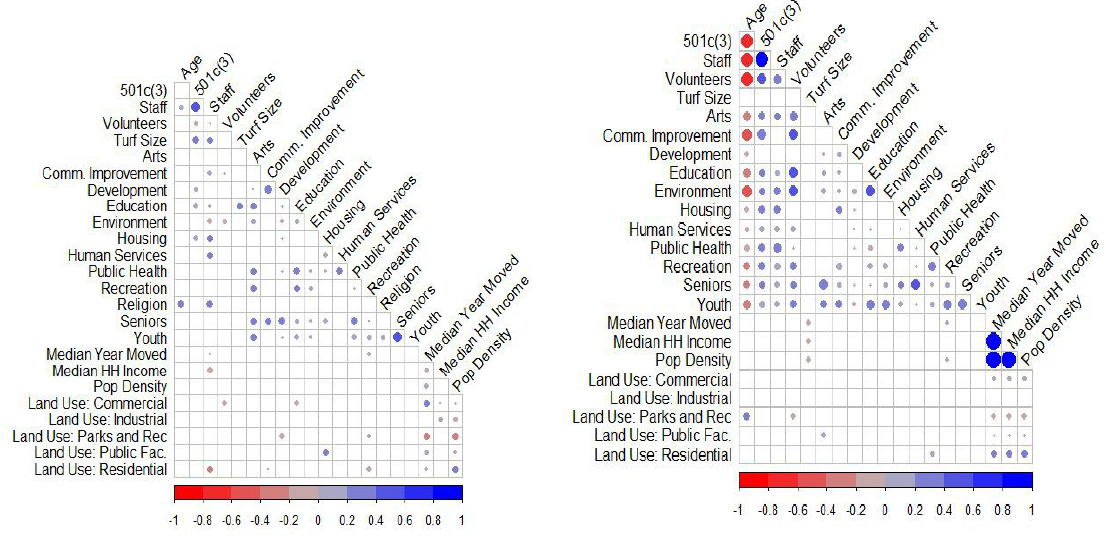
Figure A2.1: Correlation plots for vertex attributes. Philadelphia (left) and New York City